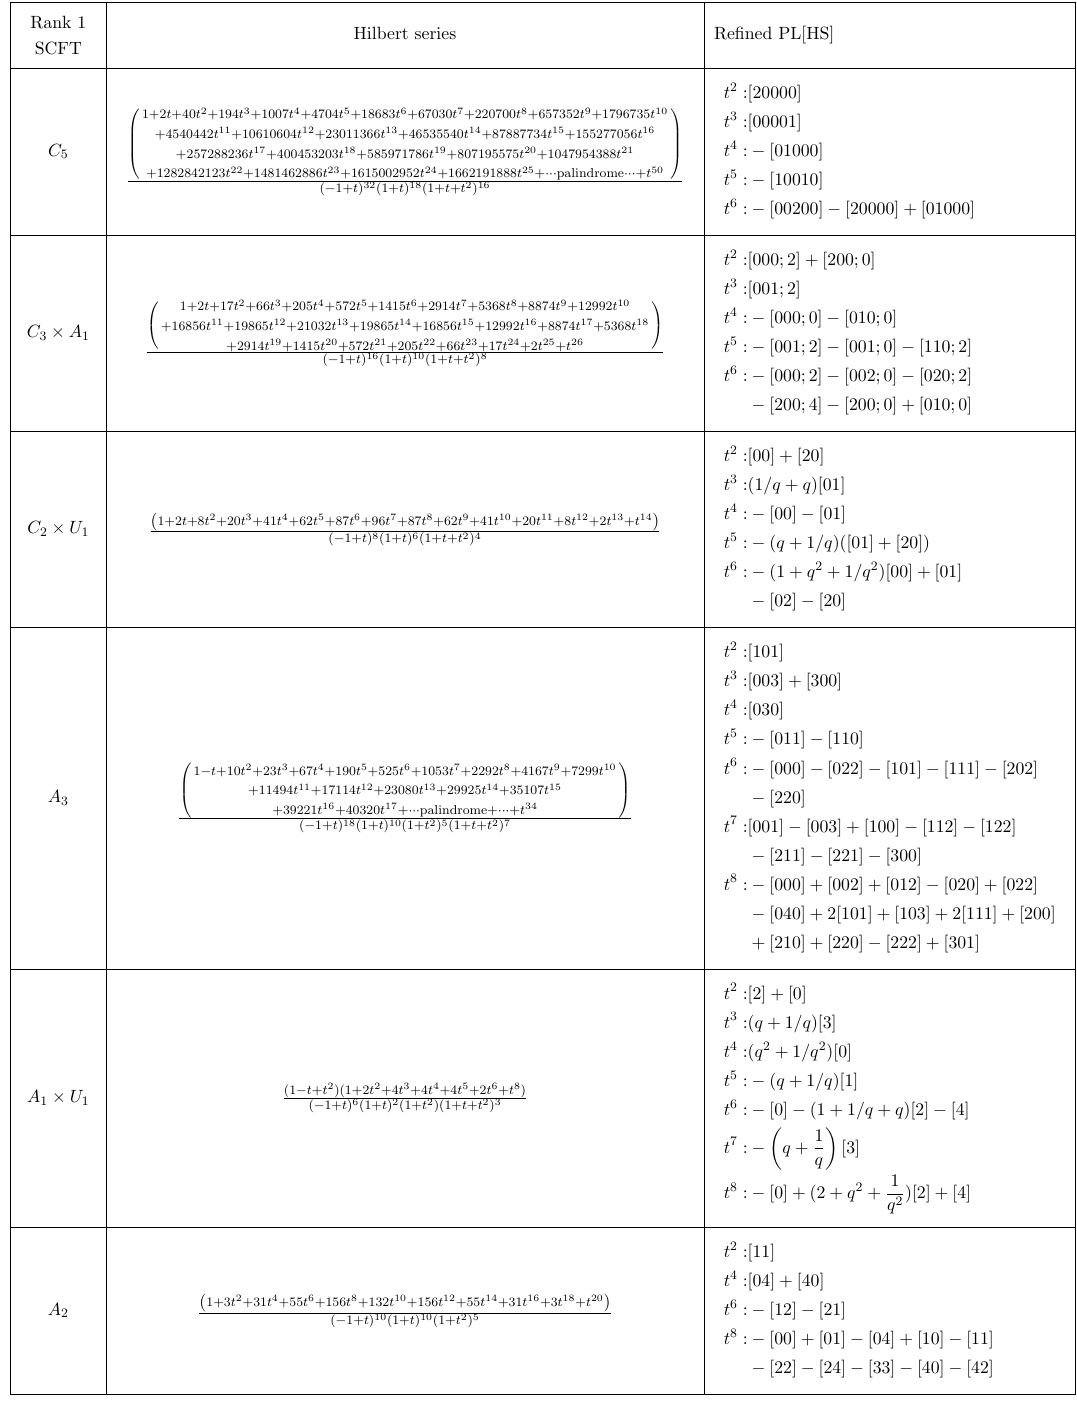
Table 3 . Higgs branch Hilbert series of the 4d = 2 SCFTs (labeled by their global symmetry) N as well as the re(cid:12)ned plethystic logarithm (PL). conformal dimension of the baryonic/instanton generators, see for example [12, section